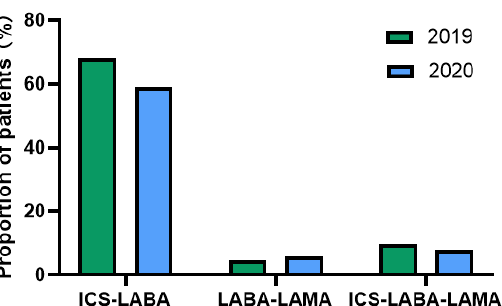
Figure 2. Mean proportion of days covered for controller inhalers. Abbreviations: LABA, long-acting β2 -agonists; LAMA, long-acting muscarinic antagonists; ICS, inhaled corticosteroid.